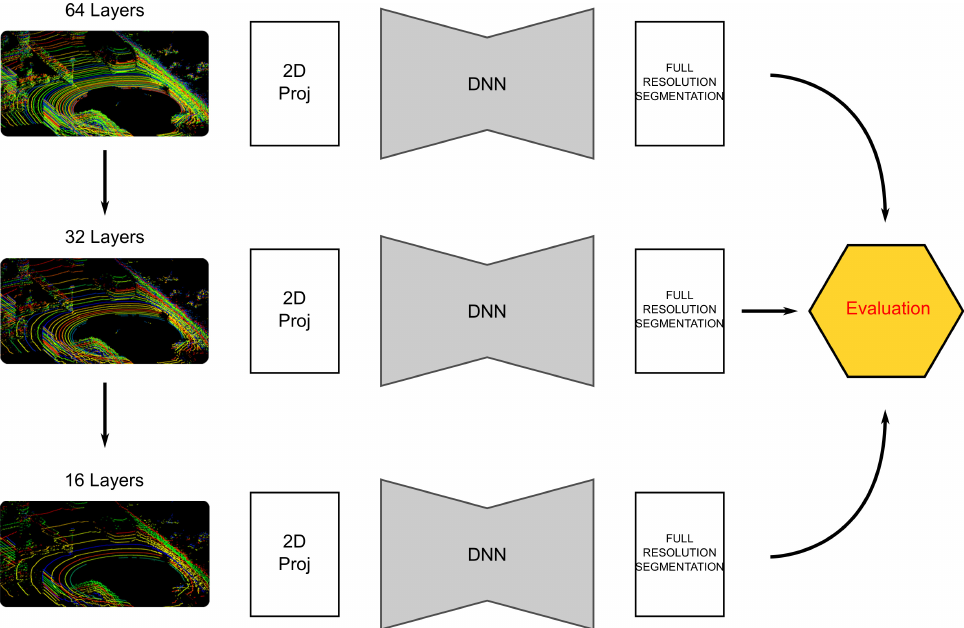
Figure 1. Overall methodology to evaluate the performance of road segmentation across different resolutions. See Figures 3 for more details on the architectures used.